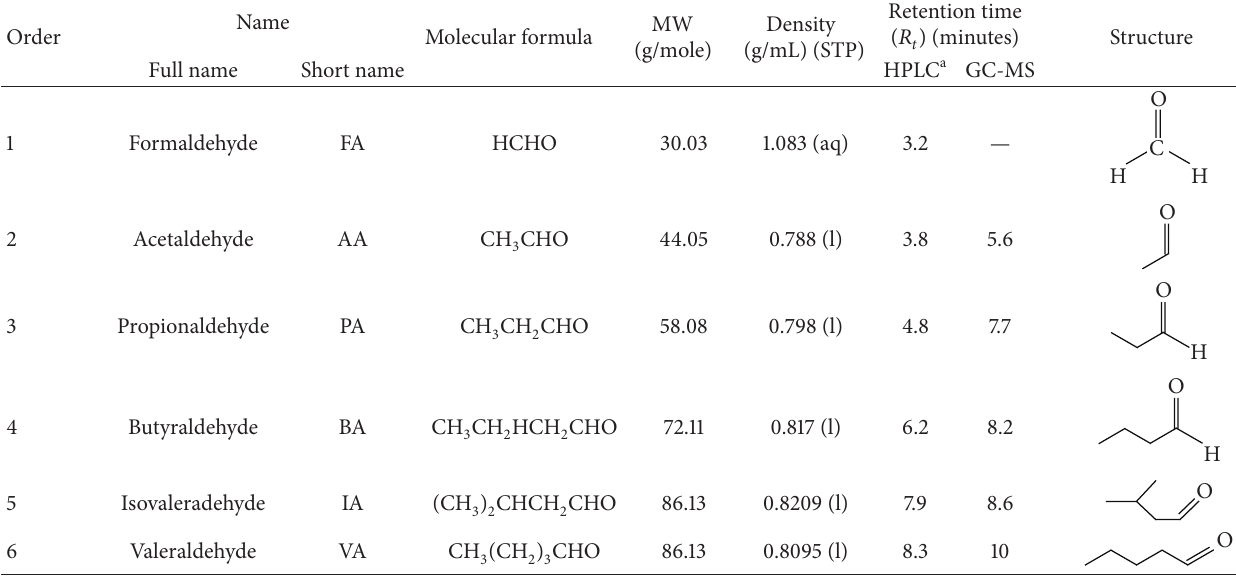
Table 1: Basic information of the target carbonyl compounds (CC) selected in this